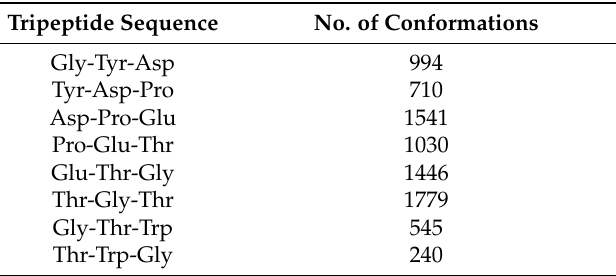
Table 1. Number of conformations (i.e., number of values of state variables) for the eight overlapping tripeptides composing